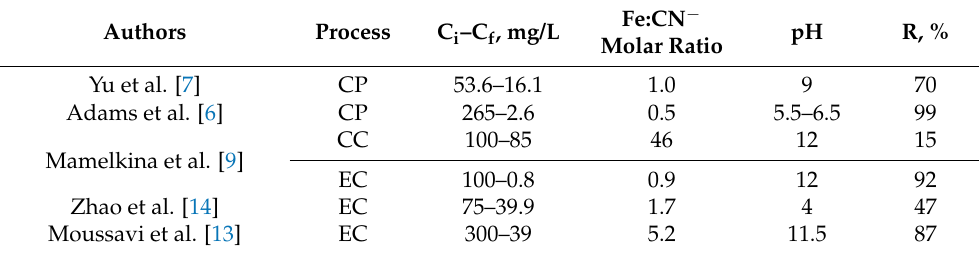
Table 1. Details of the conditions for the removal of CN − using Chemical Precipitation (CP), CC